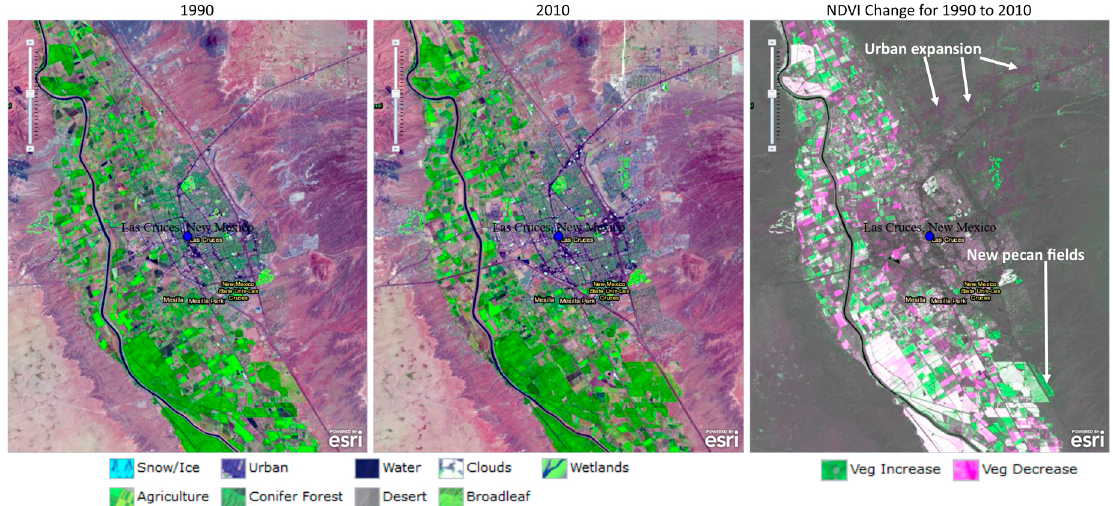
Figure 7. Visualizing land use and Normalized Difference Vegetative Index (NDVI) change around the City of Las Cruces for the years 1990 and 2010 (Source: Esri Change Matters Viewer).